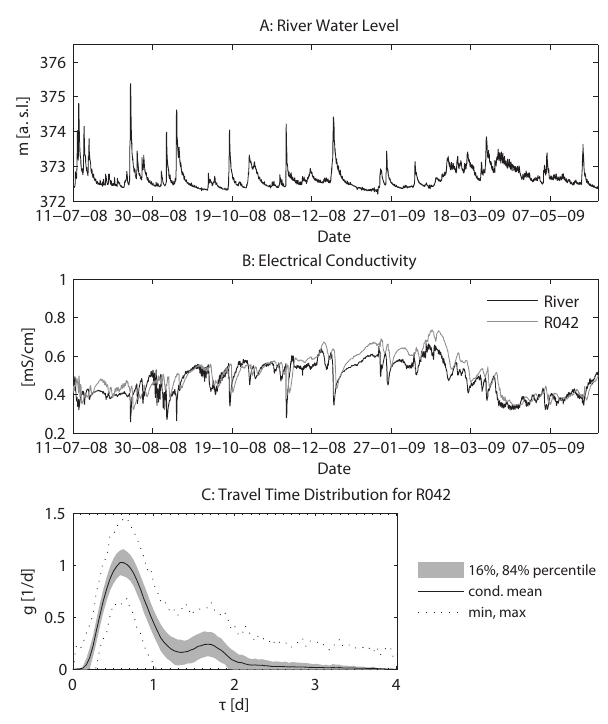
Fig. 11. River water level (A) and electrical conductivity fluctu- ations (B) in River Thur and a near-river monitoring well (R042) in the forest transect (transect B in Fig. 2). Transfer function (C) between the Thur River and monitoring well R042 obtained by de- convolution of the electrical-conductivity time series. Figure after Vogt et al. (2010a),